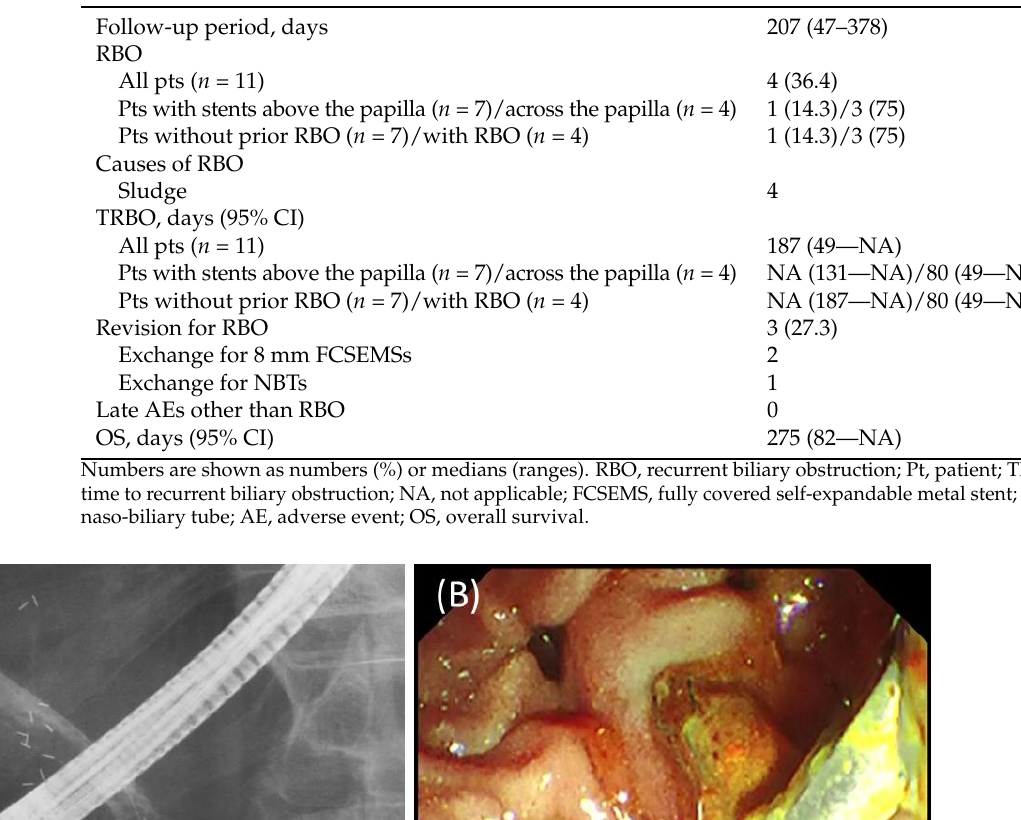
Table 3. Long-term outcomes.